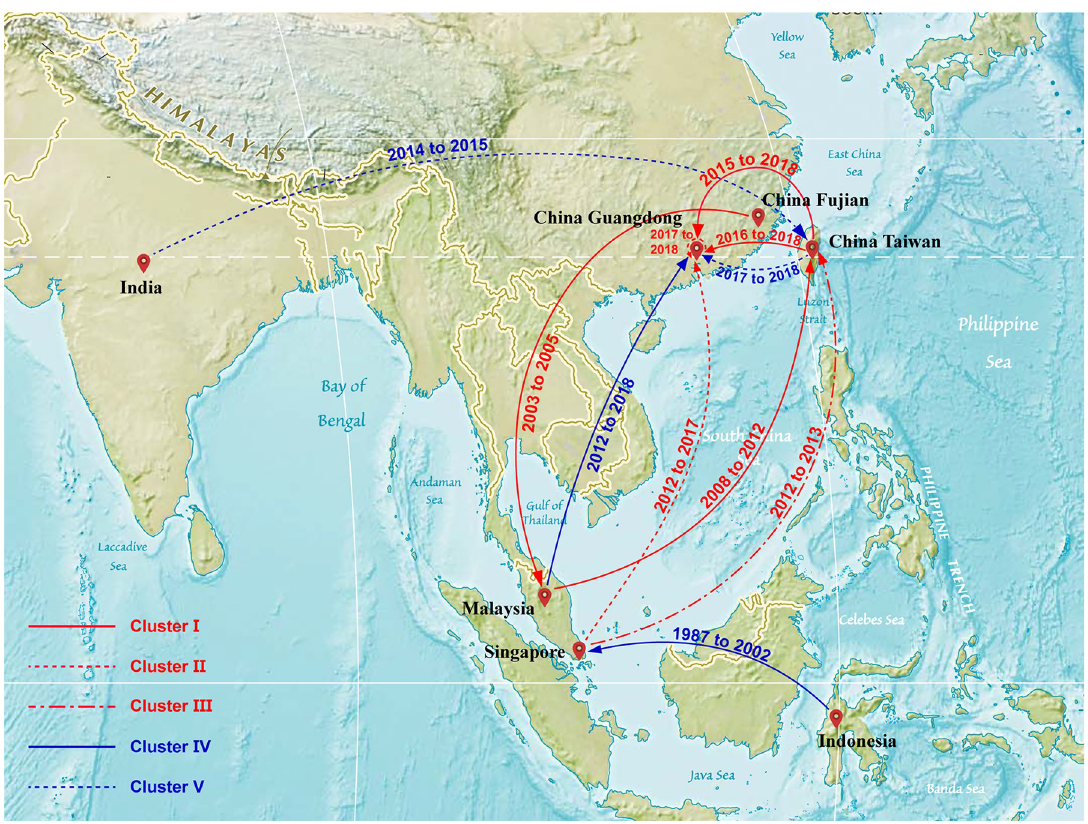
Fig 4. The propagation path map of dengue virus in Guangzhou in 2018. The propagation path map is drawn based on the paleogeography analysis. The red curves indicated that the clusters of sample sequences were belonged to DENV-1, while the blue curves belonged to DENV-2, which indicated the propagation path. The time beside the curves indicates the time range in which the virus strain is introduced, and the red flag indicates different locations.